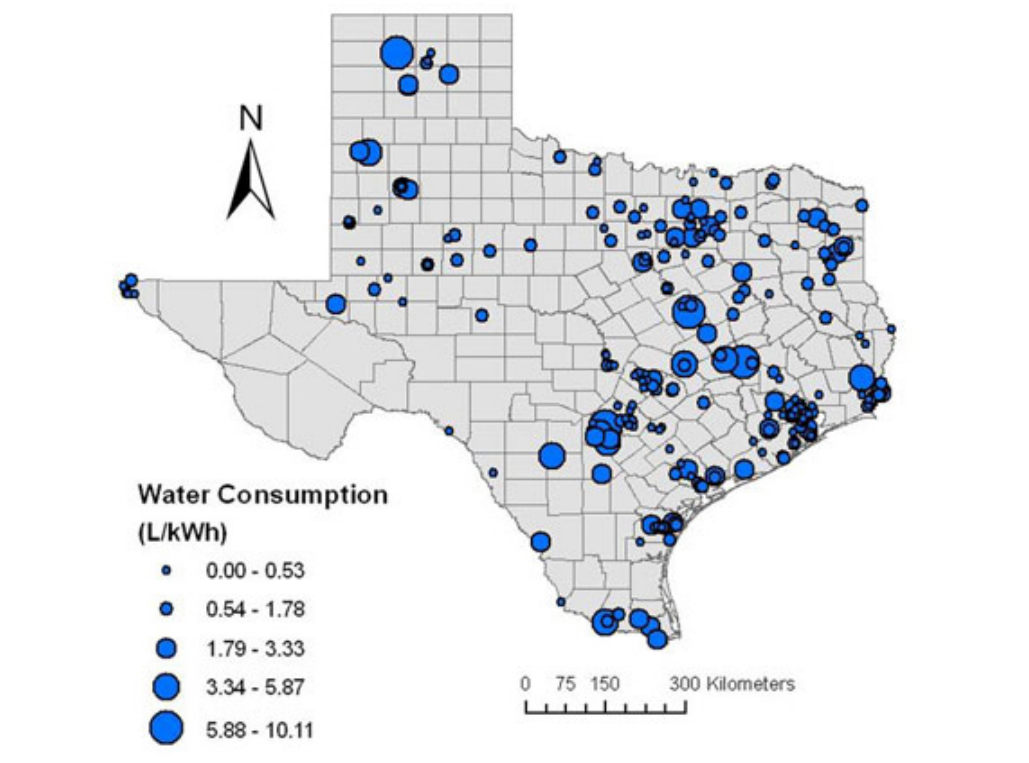
Fig. 5 . Water consumption for thermoelectric power generation in Texas (King et al. 2008). Total water consumption for electricity generation statewide is more than 595,000 megaliters annually – enough water for three million people for a year, each using 530 liters per person per day. (L/kWh: liters per